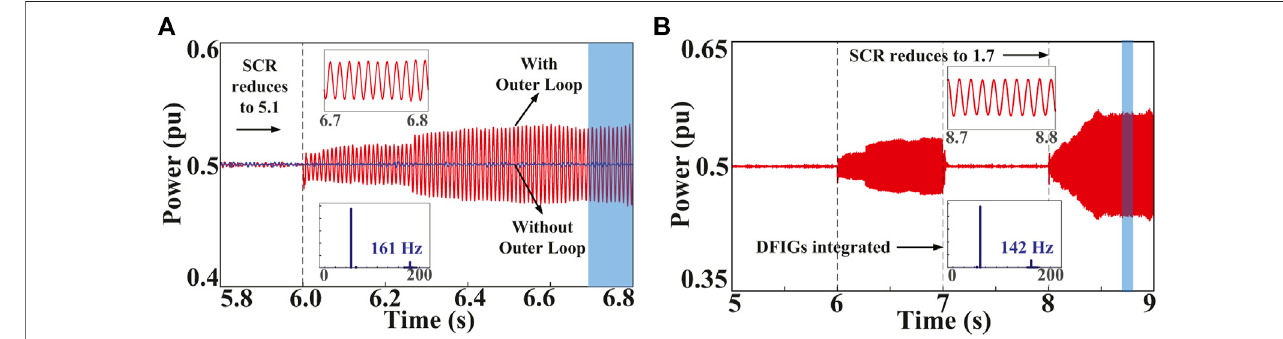
FIGURE 2 | Oscillation phenomenon. (A) The effect of the outer loop of the SEC. (B) The effect of the integration of the